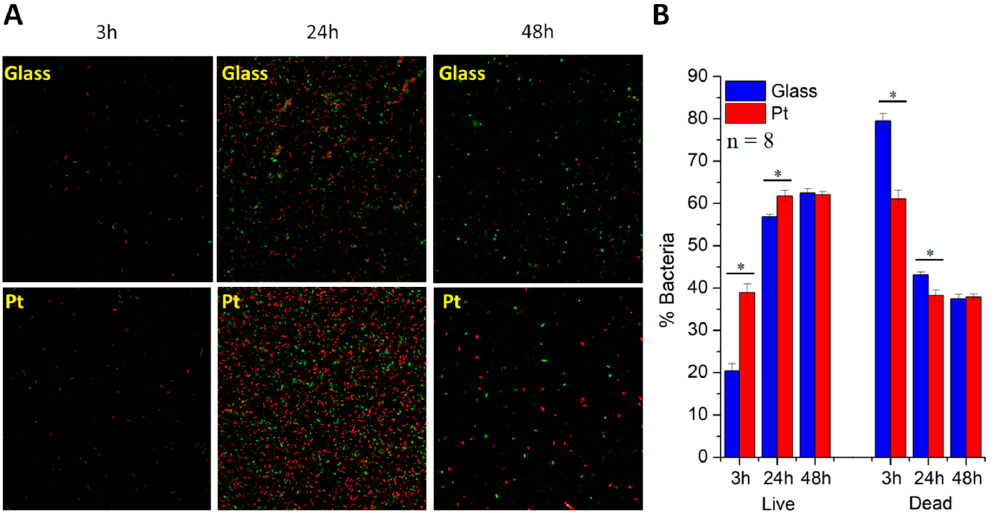
Figure 5. Viability of Escherichia coli on surfaces of glass and Pt-coated glass slides. ( A ) Confocal fluorescent microscopic images and ( B ) percentage values of live and dead bacteria after 3 h, 24 h and 48 h; * = p < 0.05, n = 8.